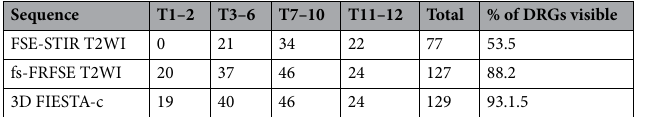
Table 1. MRI quality of visualization of